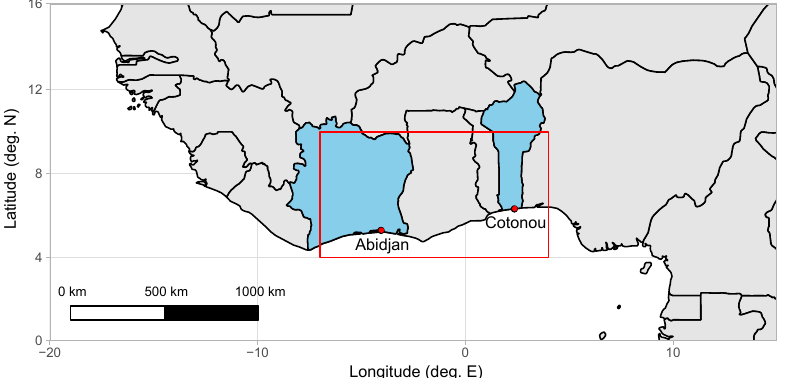
Figure 1. Geographical locations of Abidjan and Cotonou cities. The red rectangle corresponds to the geographical area between 7 ◦ W–4 ◦ E and 4–10 ◦ N (see Fig.